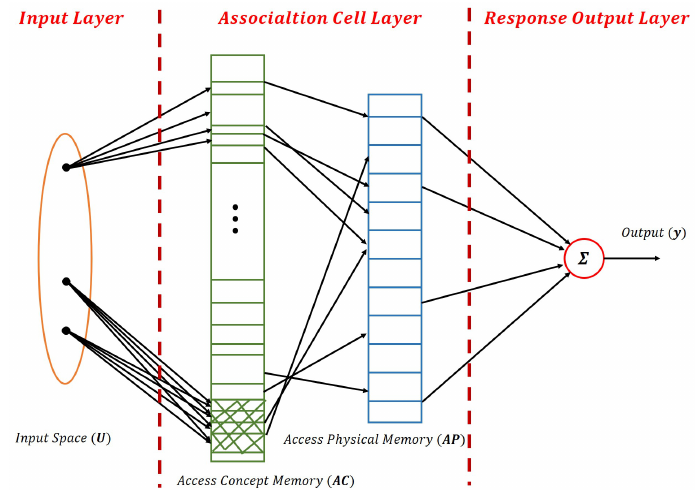
Figure 8. Classical structure of CMAC.